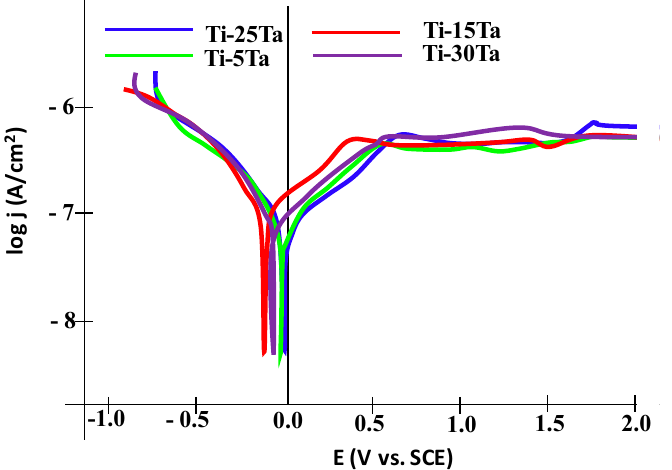
Figure 5. Polarization curves for Ti–xTa alloys. Table 4. Corrosion parameters from polarization curves (mean ± SD).